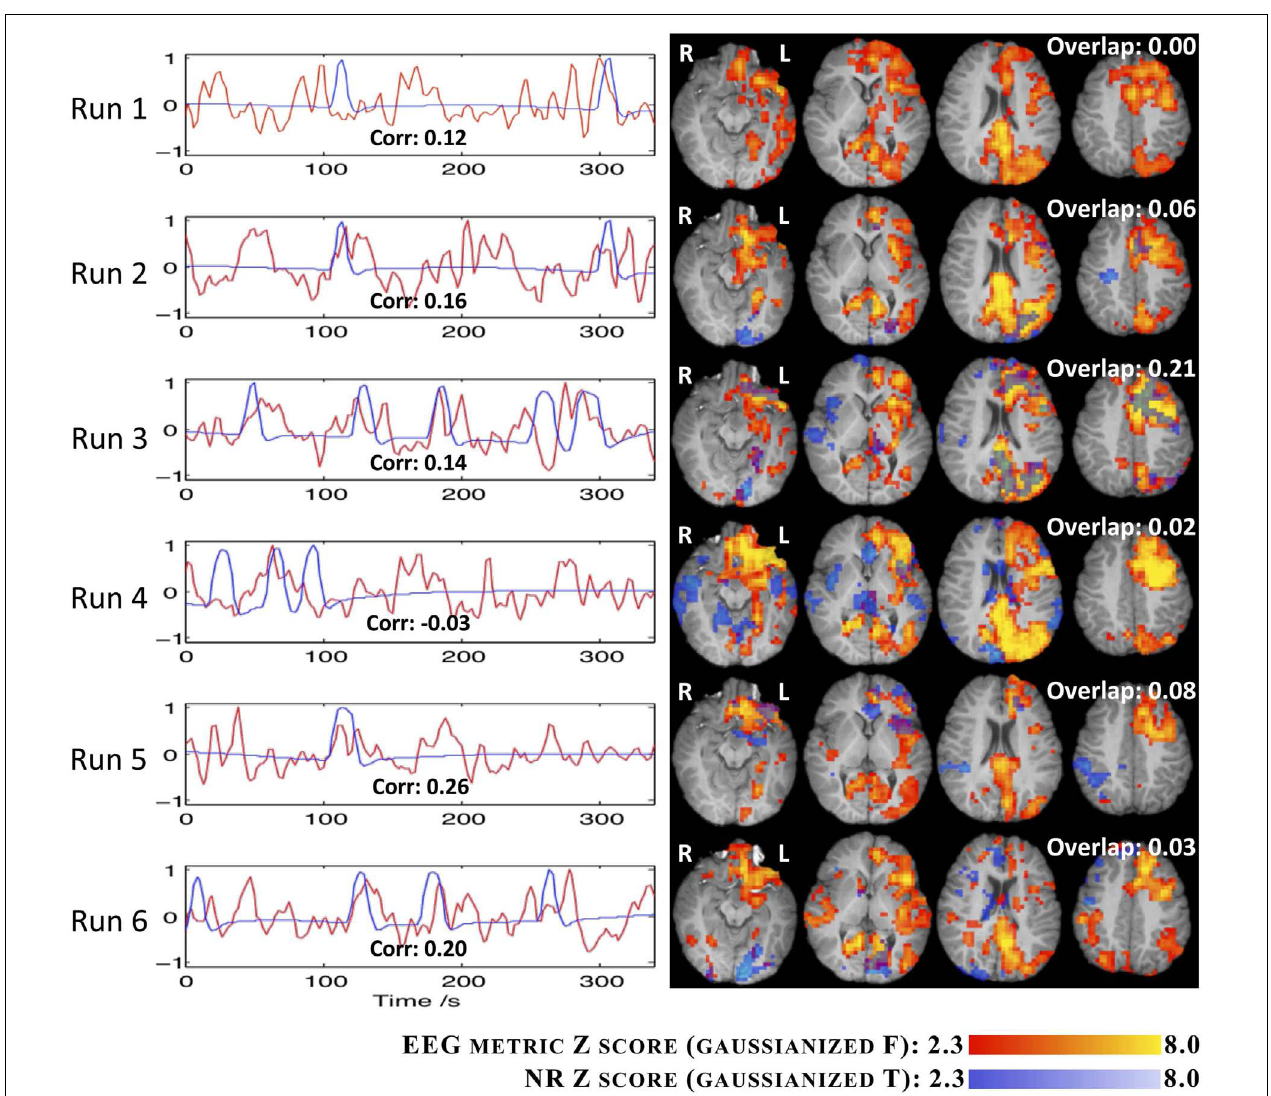
FIGURE 8 |Time courses (left) and Z statistic maps (right) of the EA (blue) and the RMSF metric for IC group II (red). The correlation between the two regressors (bottom of graphs) and the map overlap (top right of maps) are